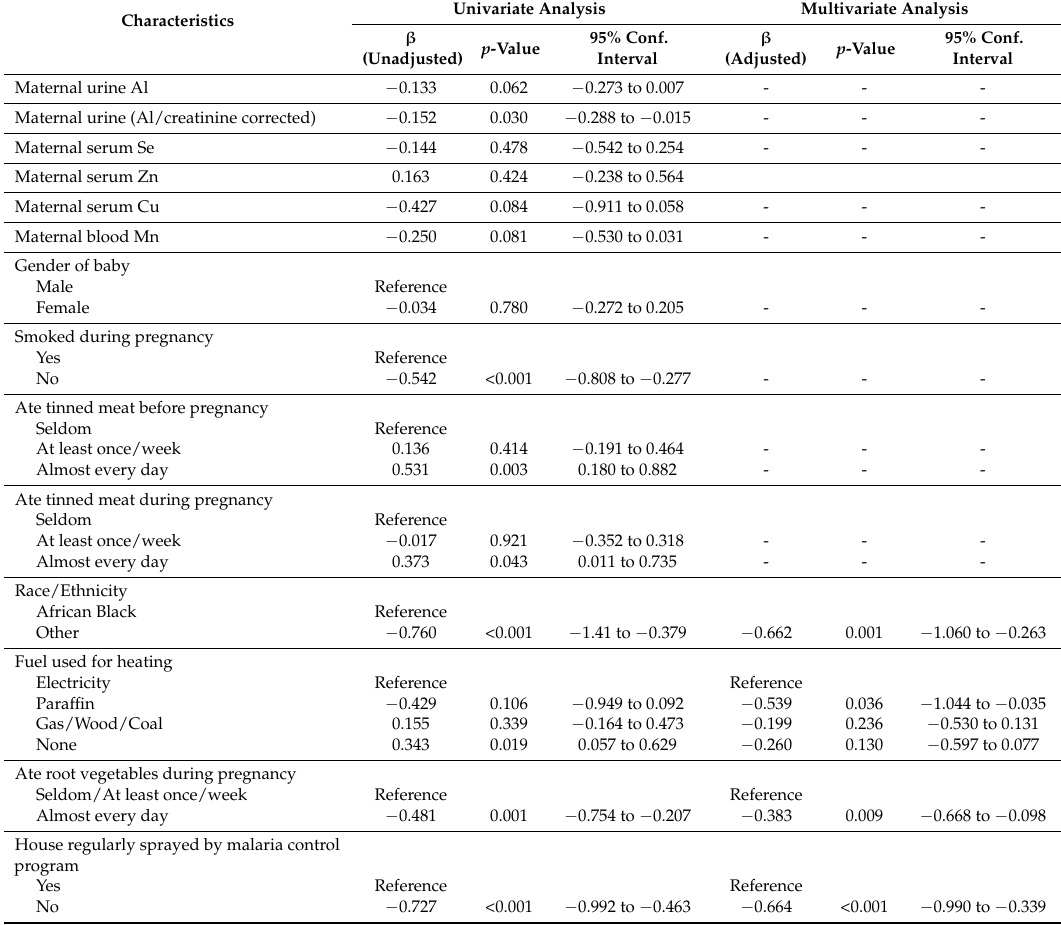
Table 6. Factors predicting Al levels in maternal serum: univariate and multivariate analyses. Univariate Analysis Multivariate Characteristics